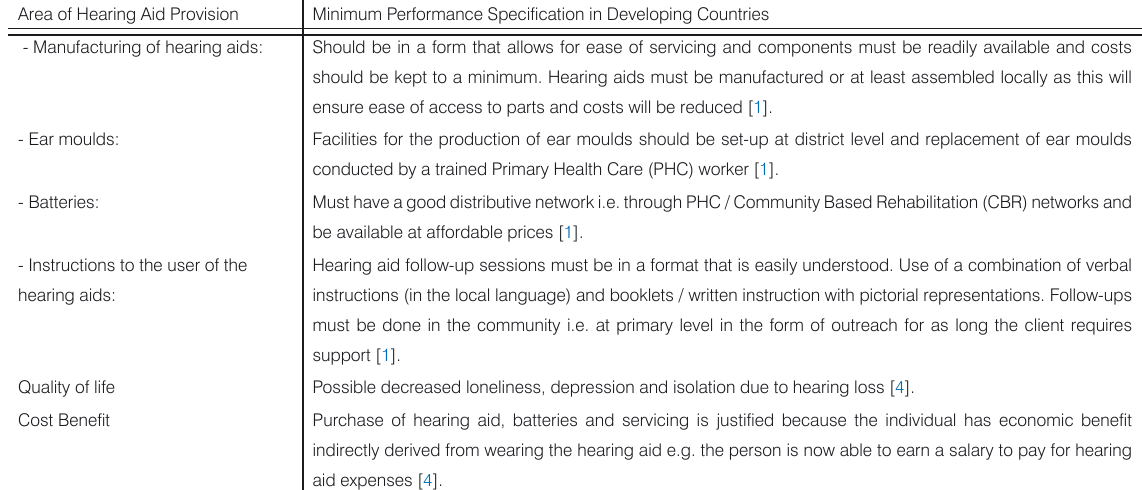
Table 2. Summary of WHO